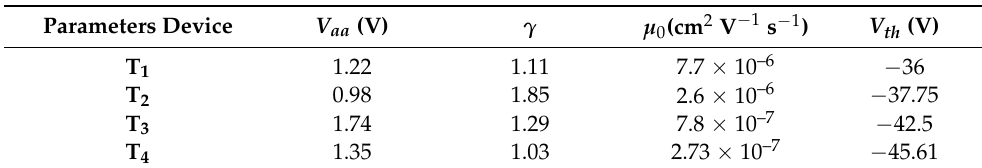
Table 3. Fitting parameters that give a fair agreement between the measured output characteristics in the linear regime and those calculated by Equation (15).